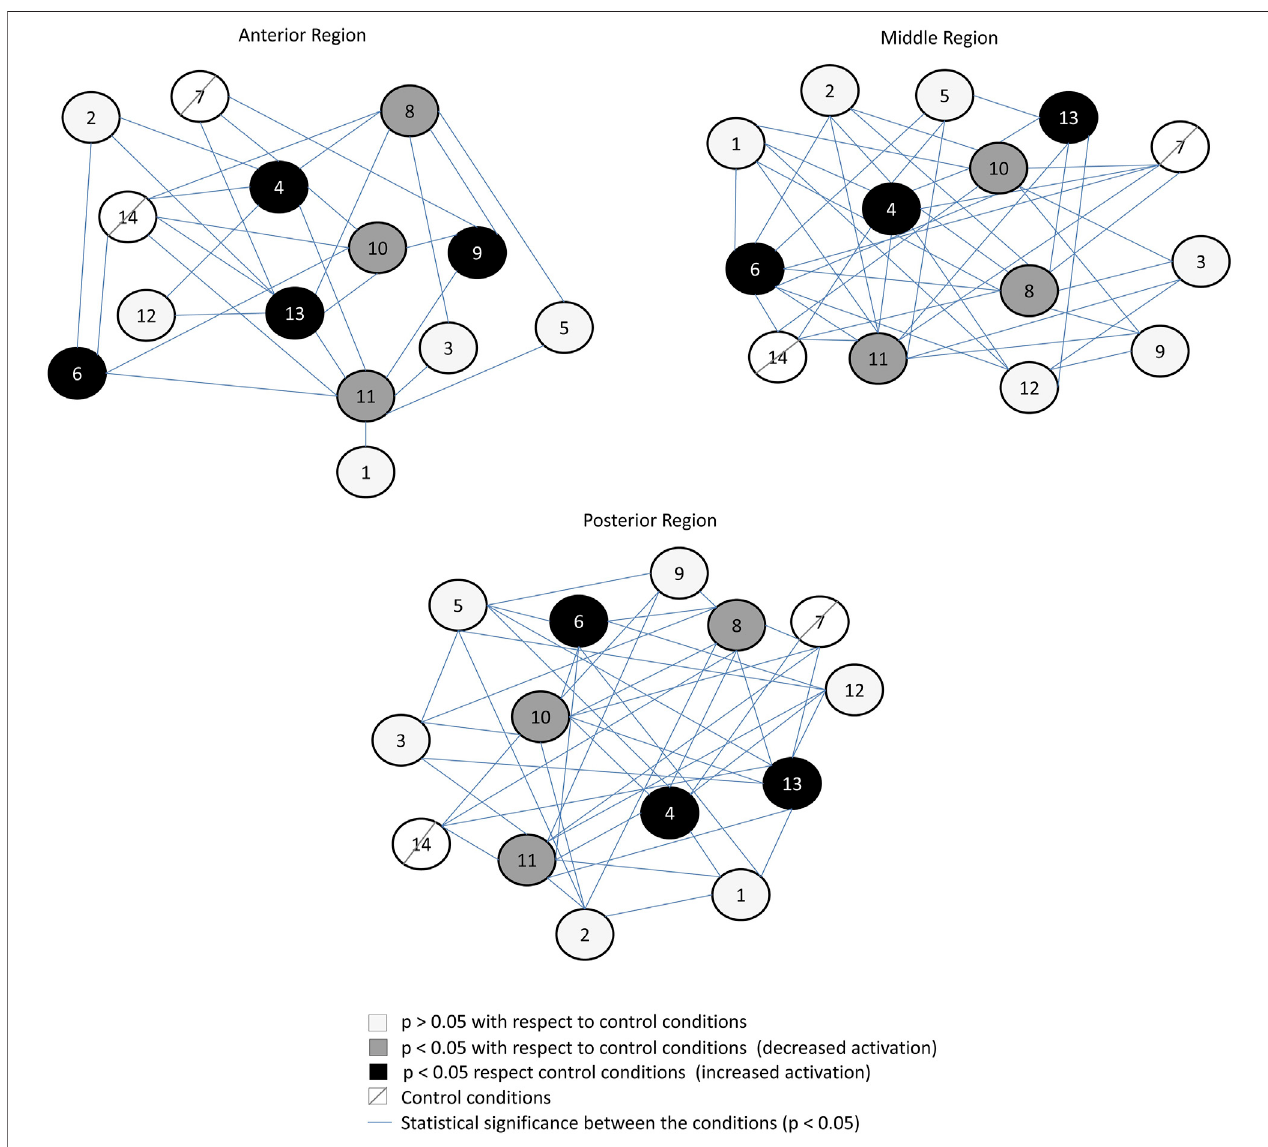
FIGURE 4 | Connection graph of the statistical differences found between conditions and regions of the gluteus medius. Conditions 7 and 14 are the control conditions (ascending stairs starting with the left and right limb, respectively).